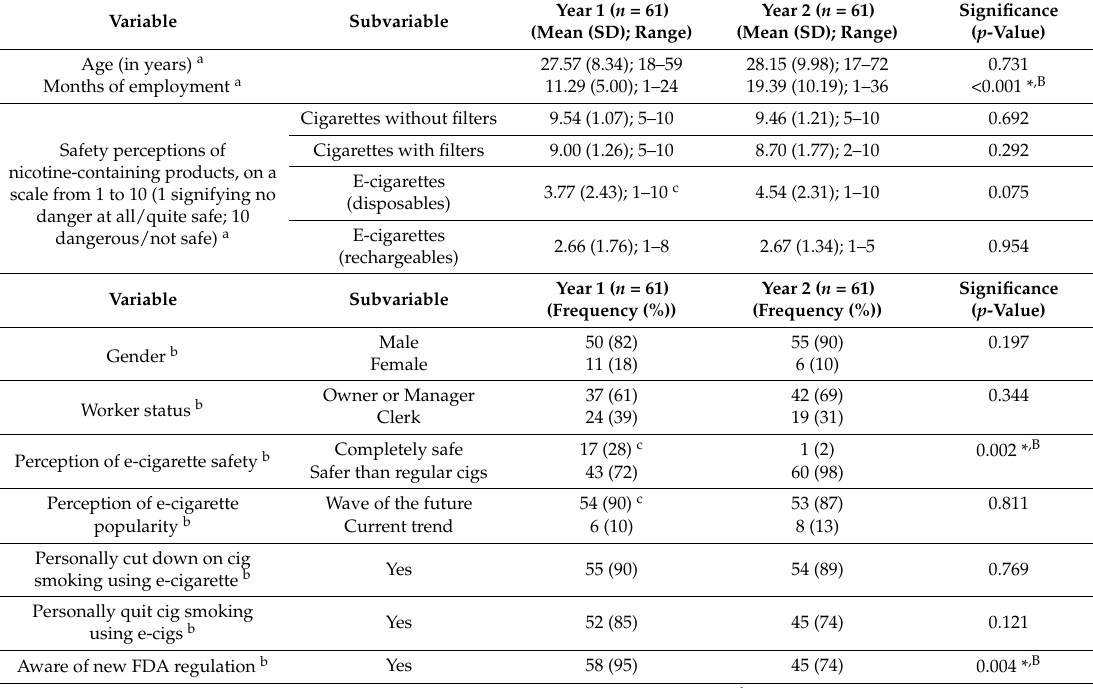
Table 1. Surveyed vape shop employees’ demographics, perceptions of e-cigarettes, personal vaping behaviors, and awareness of FDA regulations ( n = 61) using t -test or simple logistic regression. Year 1 ( n = 61) Variable Subvariable (Mean (SD);